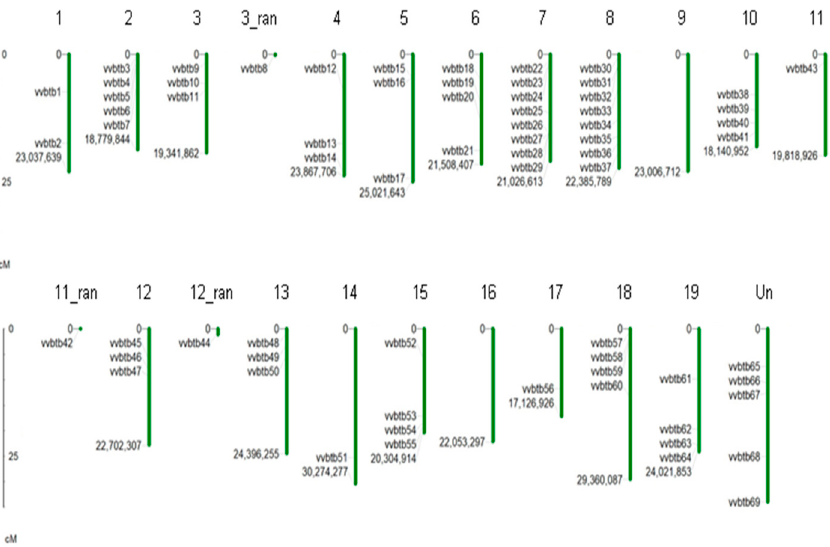
Figure 1. Chromosomal mapping of 69 BTB genes in the genome of V. vinifera. The 69 BTB genes are mapped onto grape chromosomes. Chromosome number is specified on the top of chromosome bars. The name and location of each gene is written on left side of each chromosome. The scale on the left side shows the length of chromosomes in cM (centimorgans). However, those members whose exact physical location was not known were represented as 3_ran, 11_ran and 12_ran .